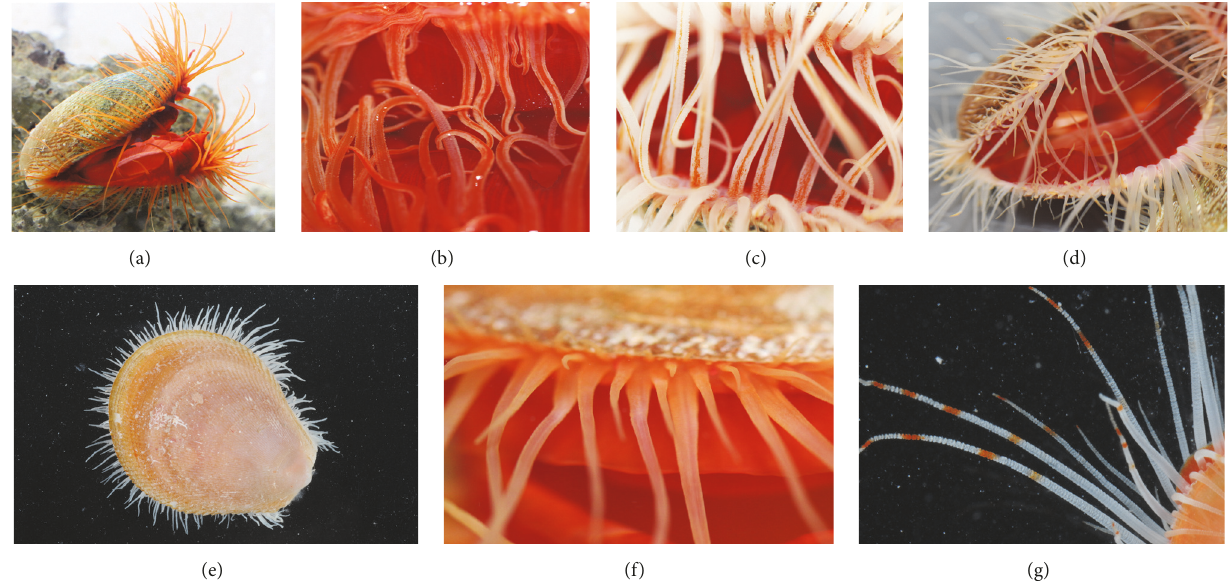
Figure 3: Tentacle color variations in Ctenoides scaber and C. mitis . C. scaber colorations included red/orange (a), red/orange with white stripes (b), white with red/orange stripes (c), or white (d). C. mitis colorations were white (e), white/orange (f), or white with red bands (g). Photo credit: L. Dougherty and J.